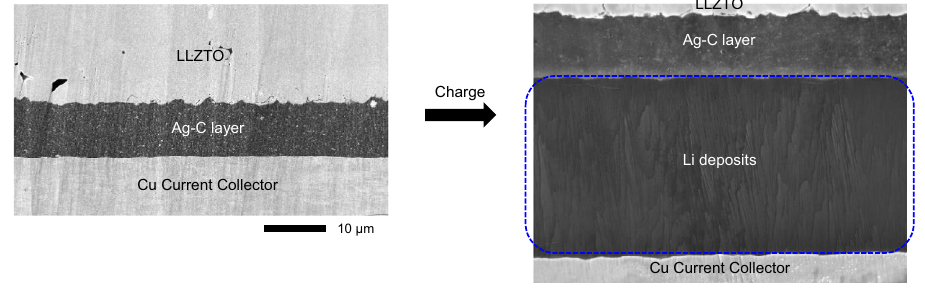
Fig. 2 | Li deposition behavior in a lab-scale cell with the Ag-C composite attached to a LLZTO pellet. Ex situ cross-section SEM image of the cell before and after lithiation, where current collector side plating is distinctly observed.